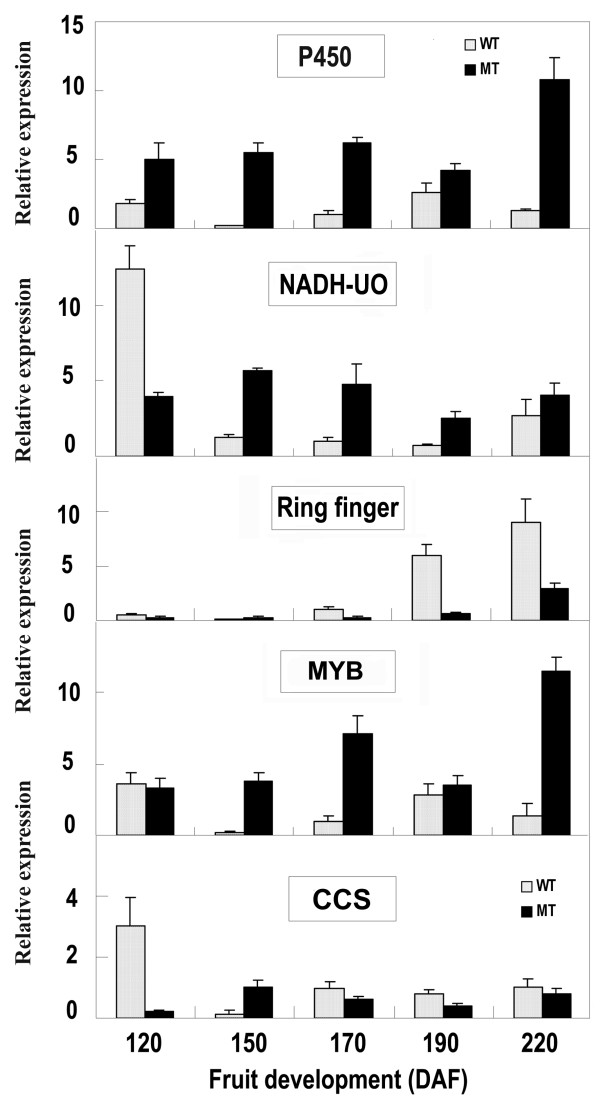
Transcript level of 5 selected genes at different stages of fruit development in the mutant (black columns) and wild type (grey columns). The relative expression levels (Y-axis) were analyzed by real-time PCR. Columns and bars represent the means and standard error (n = 3), respectively. The genes are cytochrome P450 (designated as P450 in the picture), NADH-ubiquinone oxidoreductase (NADH-UO), Ring finger gene (Ring finger), MYB transcription factor (MYB), and Capsanthin/capsorubin synthase gene (CCS).